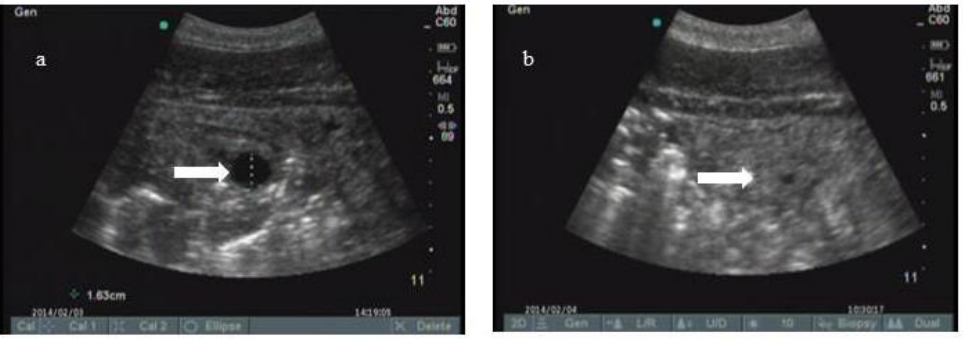
Figure 3. Animal 3 ultrasound. a) white arrow points to pre-ovulatory follicle, b) white arrow points to corpus hemorrhagic.